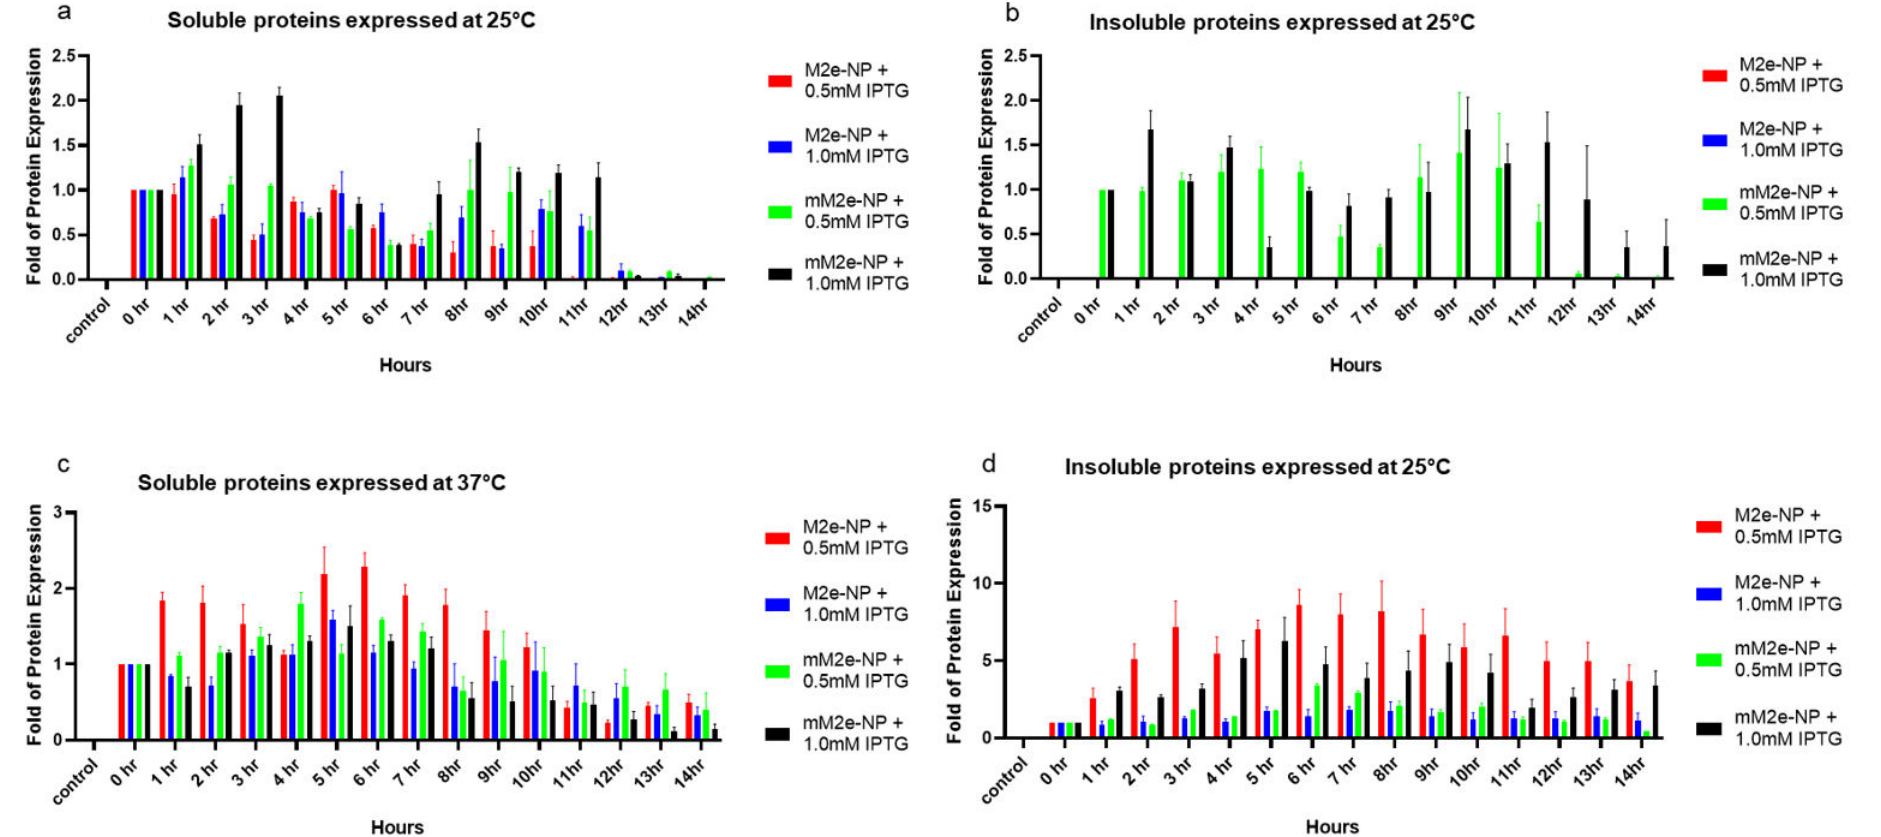
Figure 4. Folds of protein expression compared to the fusion proteins harvested at 0 h (prior to the addition of IPTG). The upper and lower panels represent protein yields at 25 ◦ C and 37 ◦ C, respectively. ( a ) Soluble and ( b ) insoluble M2e-NP and mM2e-NP harvested at 25 ◦ C, and ( c ) soluble and ( d ) insoluble M2e-NP and mM2e-NP harvested at 37 ◦ C. The quantitaion was performed in triplicate ( n = 3), the data were presented as mean ±